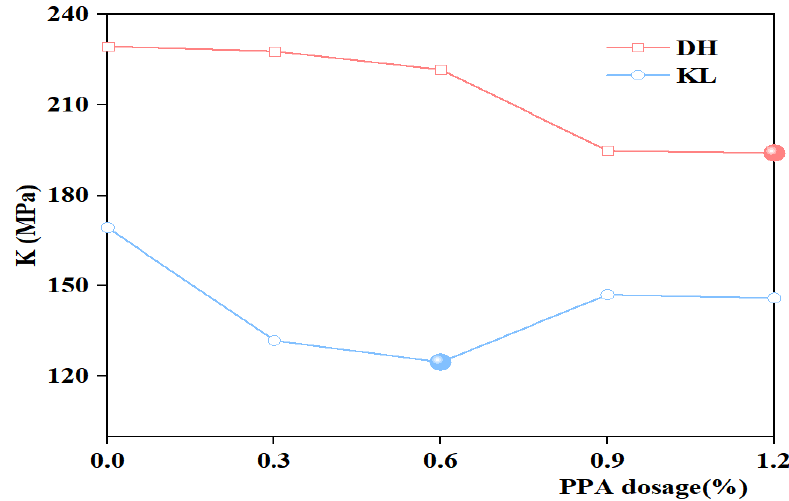
Figure 8. K index of single modified asphalt with different PPA dosages.